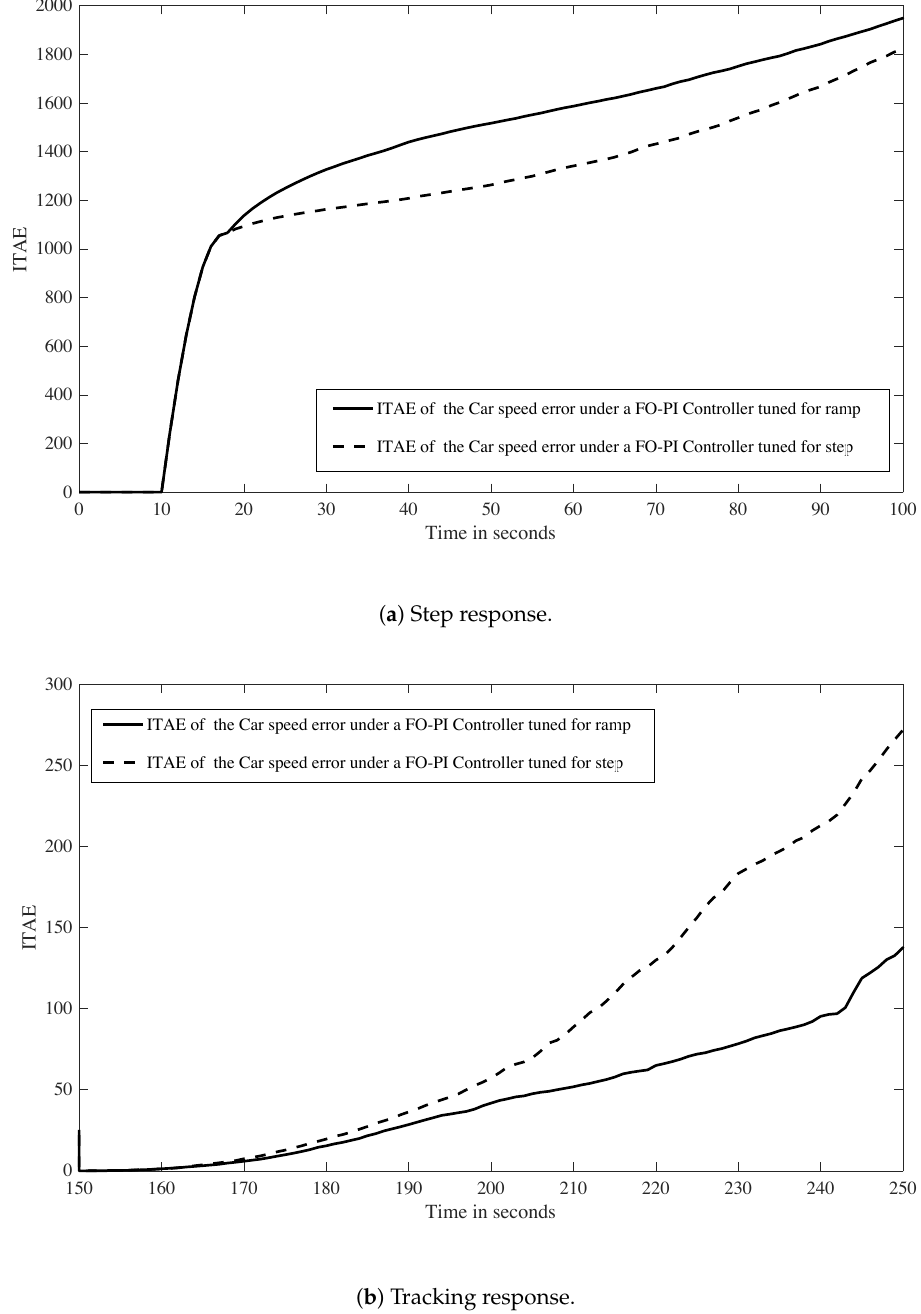
Figure 17. ITAE of the car speed with the system under FO-PI